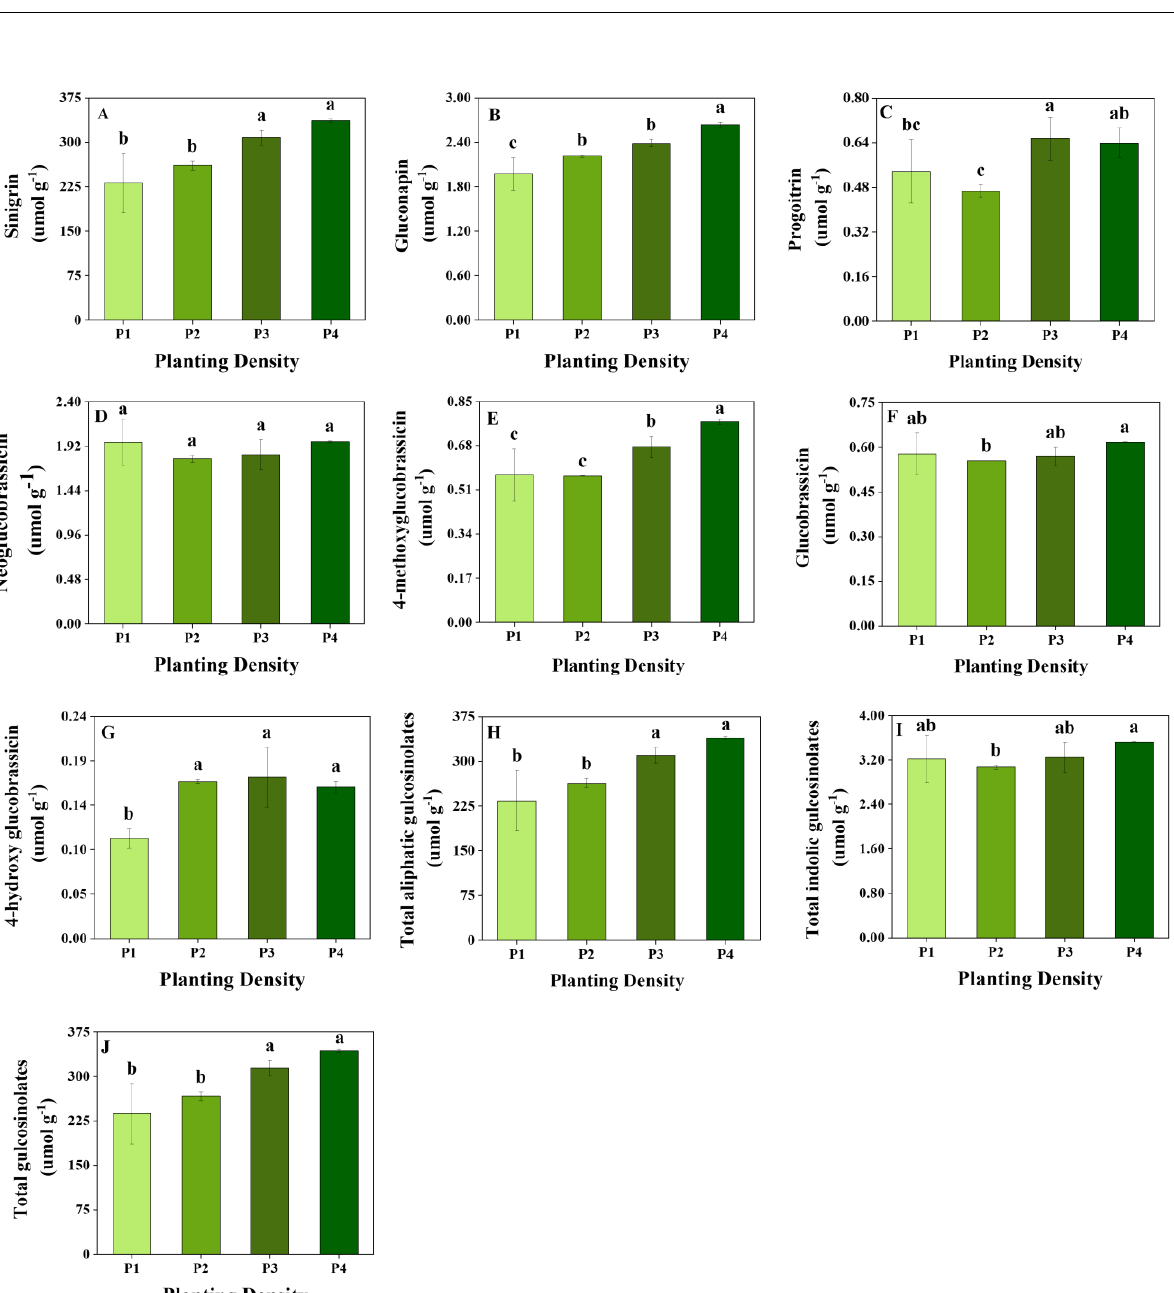
expressed as mean ± standard deviation. Same letter in the same figure means no significant differ-